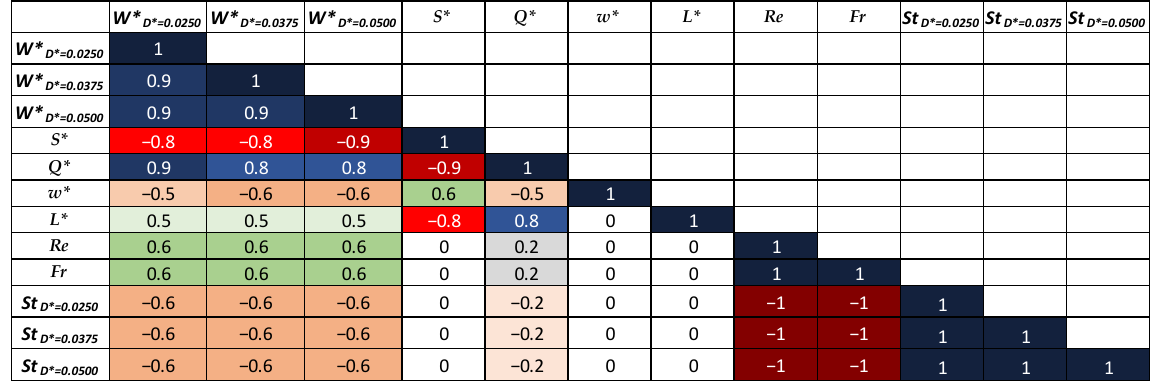
Figure 2. Correlation matrix.